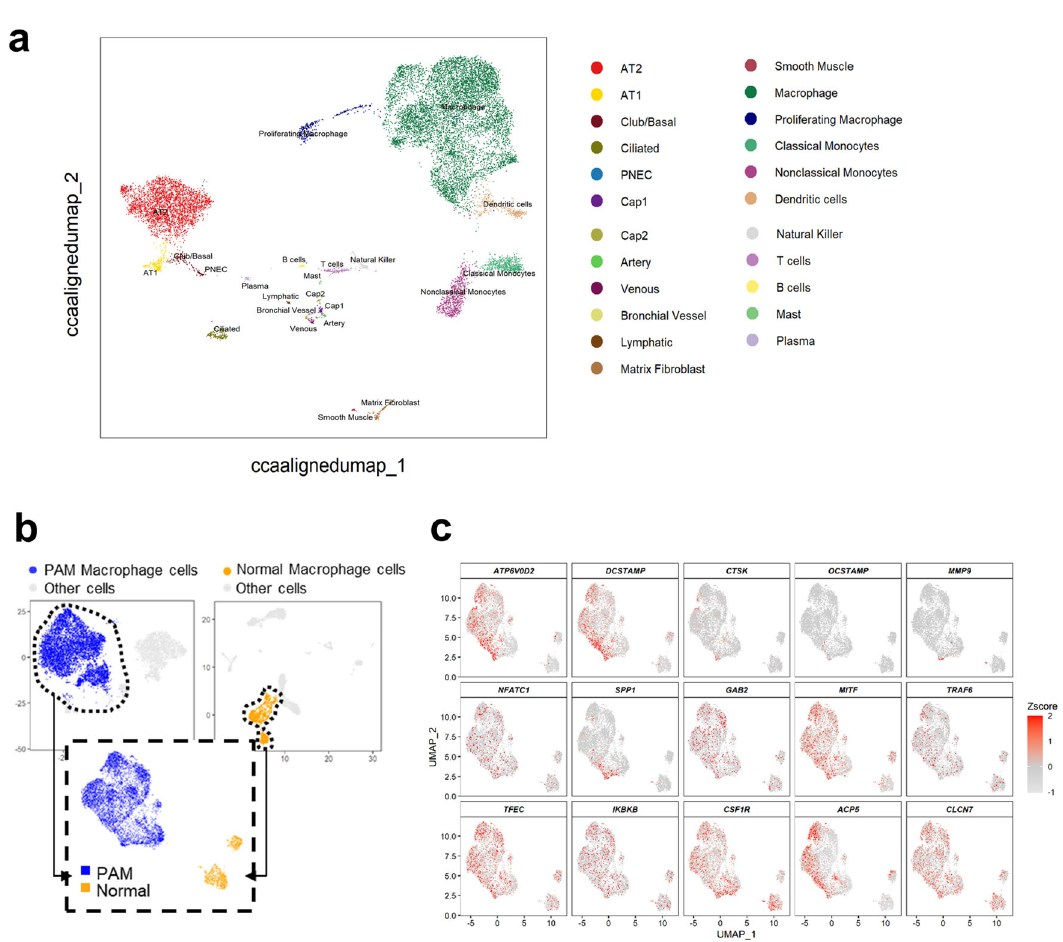
Fig. 2 | Integrated Single-cell RNA-seq analysis identi fi es diverse cell popula- tions. a Uniform Manifold Approximation and Projection (UMAP) representation of 14,210 cells from PAM and control donor lung samples. Twenty-three cellular populations were identi fi ed, each dot represents a single cell and cells are color coded to represent cell identity. A reference-based machine learning cell type annotation algorithm (SingleR) was used to predict the cell populations. b